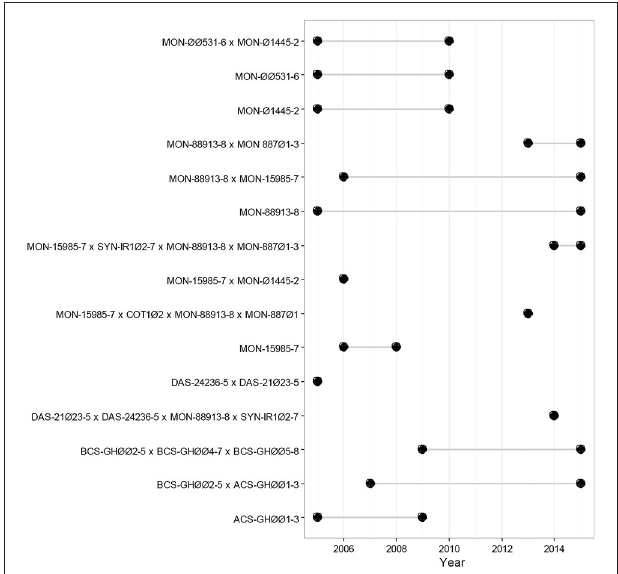
FIGURE 1 | Timeline for GM cotton transformation events released in Mexico. Black dots indicate the first and last year that each release was requested. The figure shows the different GM cotton released applications that have received a permit in Mexico, from 2005 until 2015 ( CIBIOGEM,